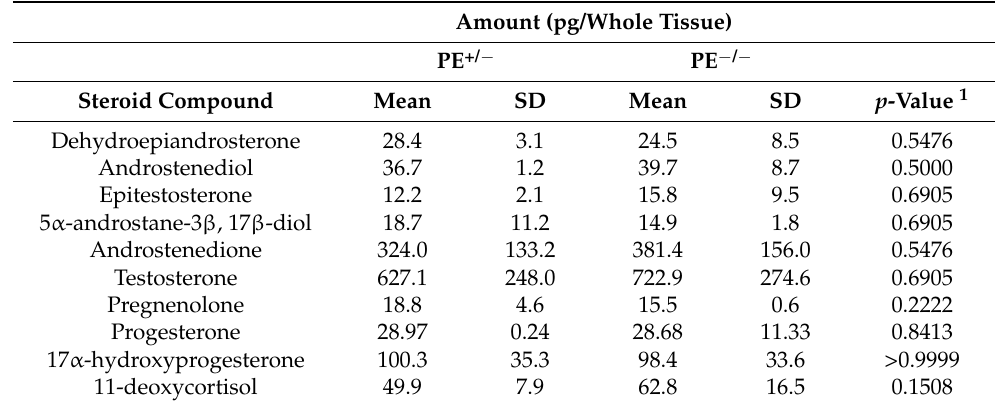
Table 1. Intratesticular steroids in PE +/ − mice and PE − / − mice at E18.5.